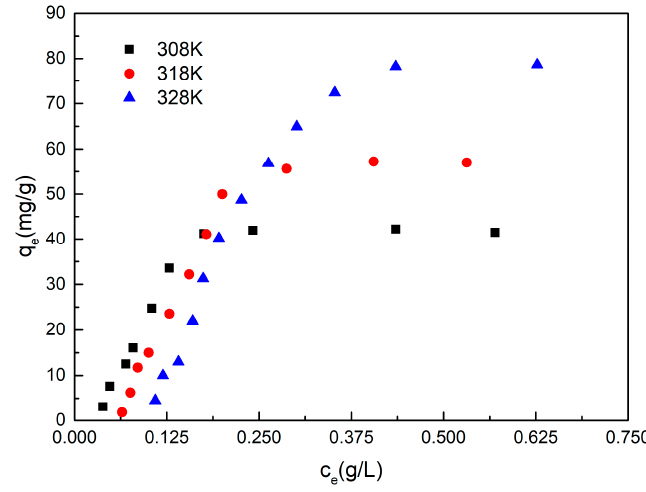
Figure 1. Adsorption isotherms of NPEO 10 on lignite. Table 1. Langmuir and Freundlich isotherm constants for NPEO 10 onto coal sample coal at different temperatures.